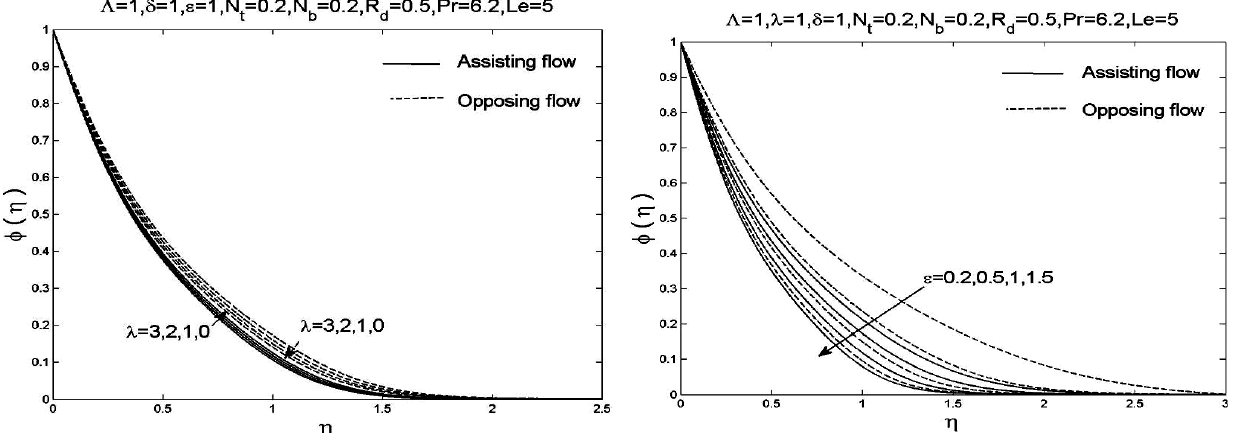
Fig. 21. The effect of the buoyancy parameter λ on the concentra- tion profiles ( ) φη .